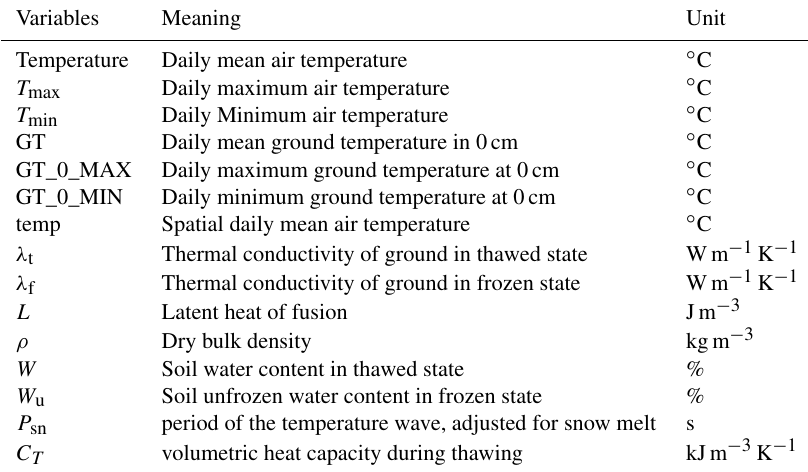
Table 2. Input data and parameters.